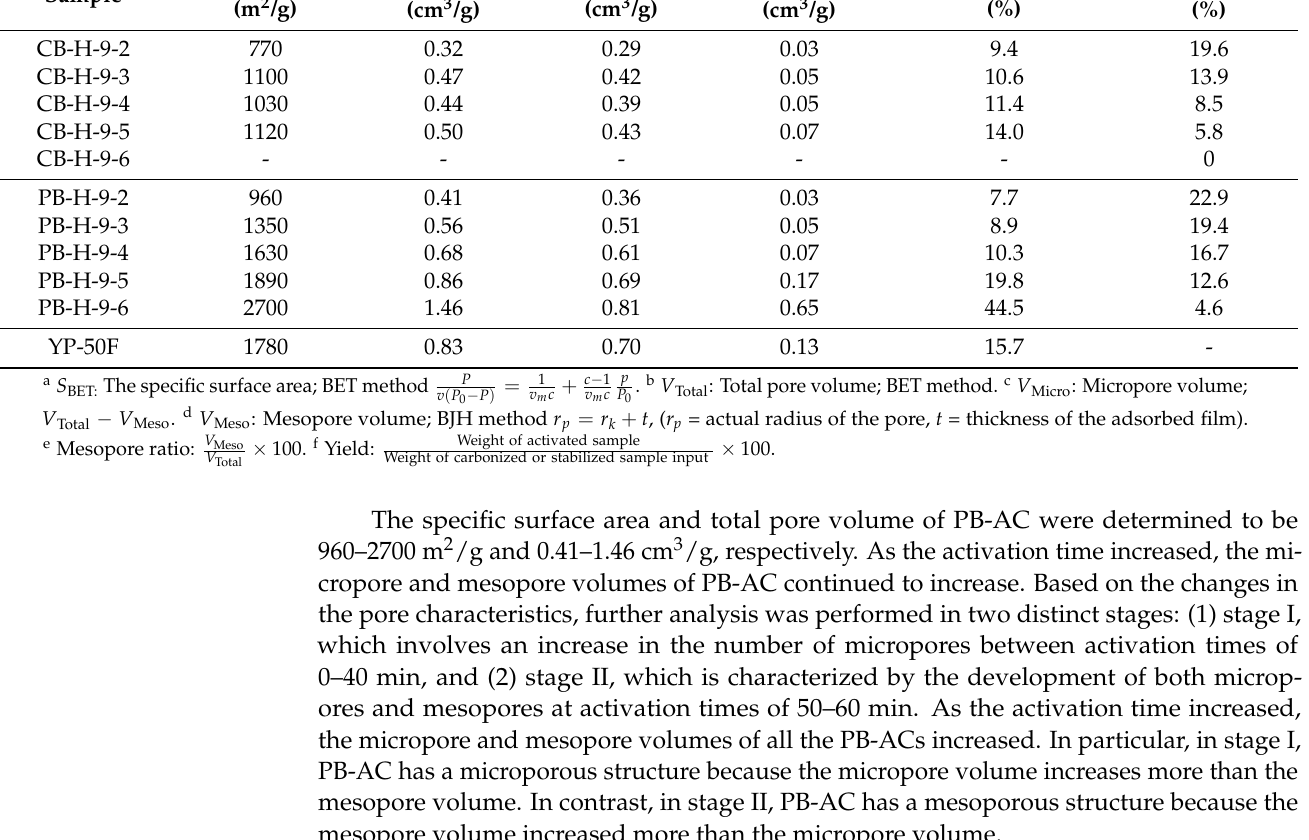
Figure 1. N 2 /77 K isotherm adsorption–desorption curves of ( a ) CB-AC; ( b ) PB-AC. Table 1 lists the textural properties of CB-AC and PB-AC. As the activation time increased, the yields of CB-AC and PB-AC continued to decrease because of crystallite oxidation. In general, the CB-AC samples had lower specific surface areas and total pore volumes than the PB-AC samples prepared under the same activation conditions. The spe- cific surface area and total pore volume of CB-AC were determined to be 770–1120 m 2 /g and 0.32–0.50 cm 3 /g, respectively. As the activation time increased, the micropore volume of CB-AC increased, but only up to a maximum activation time of 30 min, subsequently remaining constant. On the other hand, the mesopore volume of CB-AC increased to 0.03–0.07 cm 3 /g as the activation time increased. Table 1. Textural properties of bamboo-derived activated carbon samples as a function of activation conditions.